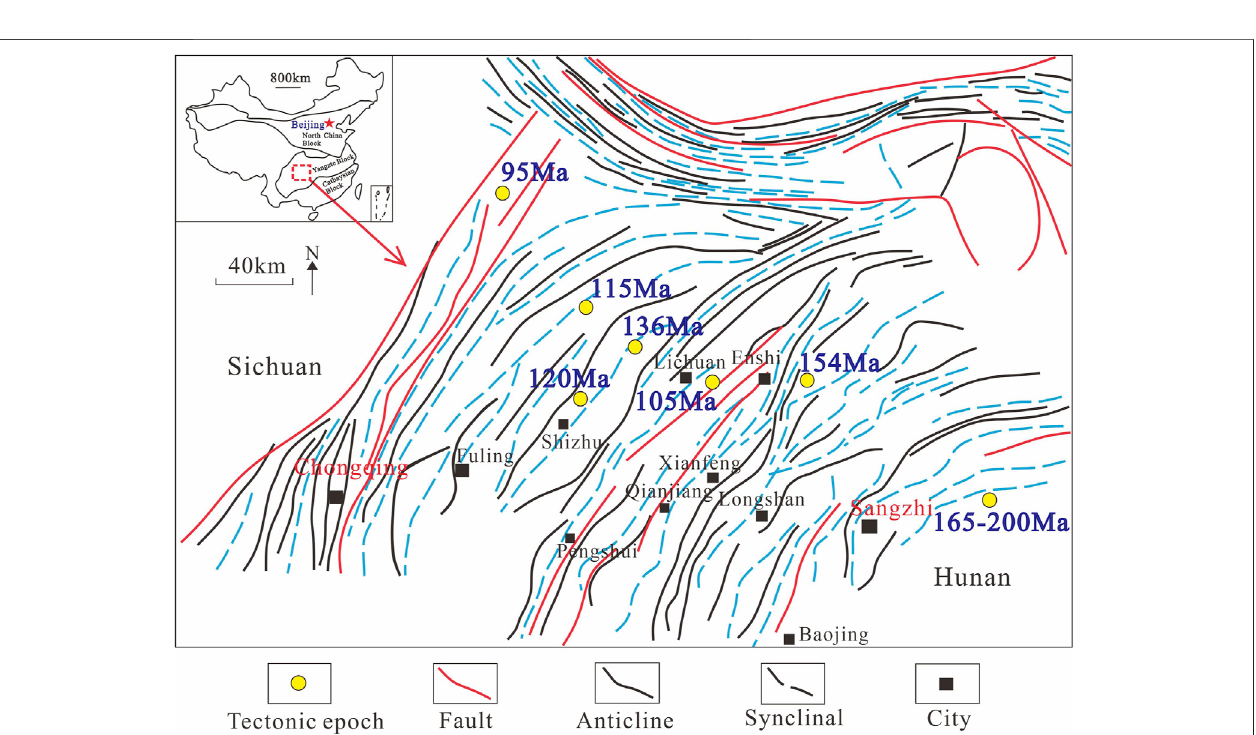
FIGURE 12 | Tectonic activity age in Chongqing and Hunan regions, revised from Zhai et al. (2017).